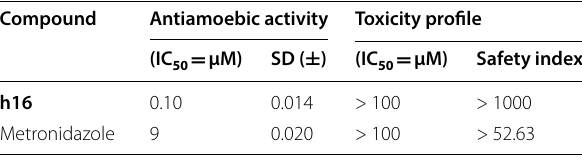
Table 53 Antiamoebic activity and toxicity